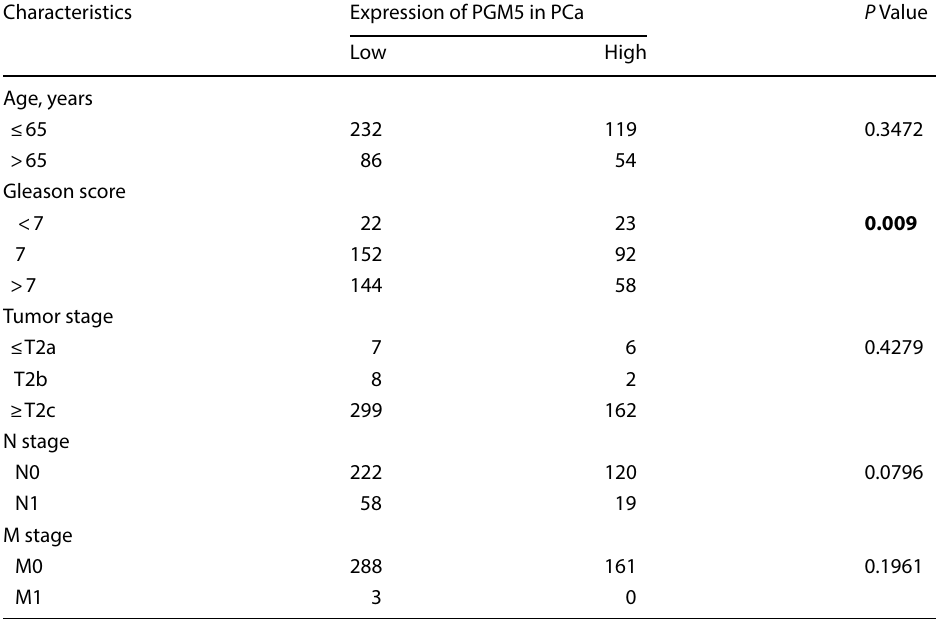
Table 1 Clinical Characteristics of PCa Patients and PGM5 Expression in